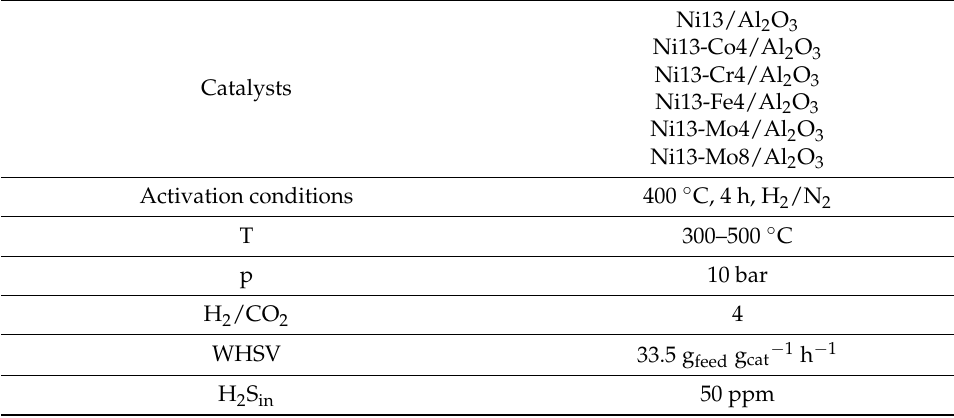
Table 17. Catalysts and reaction conditions for experiments on H 2 S influence with Ni/Al 2 O 3 and Co, Cr, Fe, and Mo as promoter